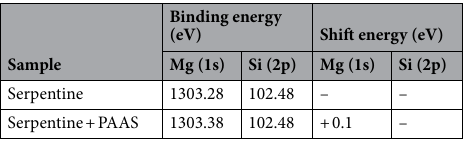
Table 5. Binding energies of elements on the serpentine surface.